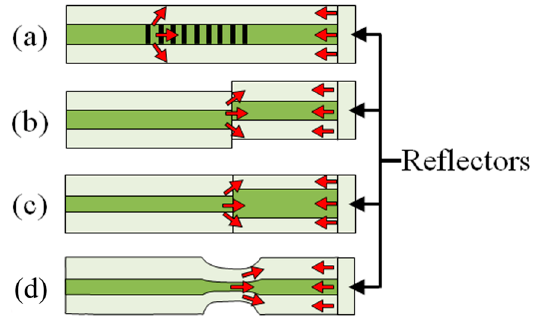
Figure 9. Example configurations for in-line Michelson interferometers: ( a ) Long-period fiber grating; ( b ) core-offset; ( c ) core diameter mismatch; ( d ) fiber tapering.